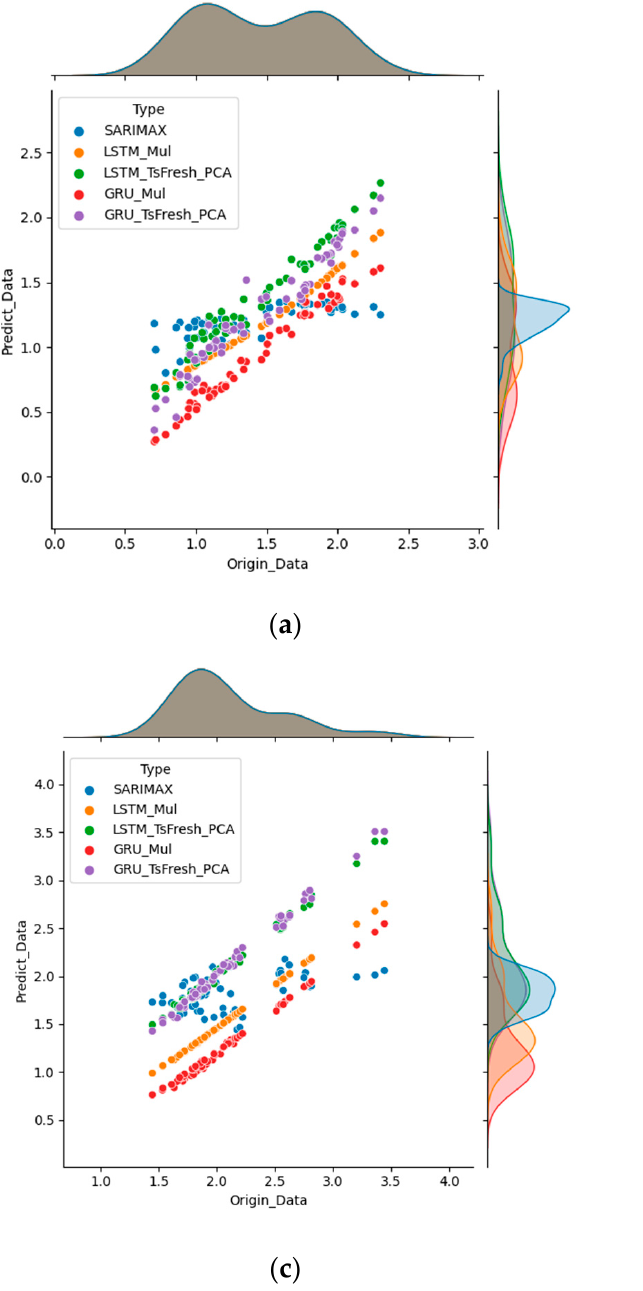
Figure 11. Scatter plots of different model fit. ( a ) Scatterplot of model fit for the spring dataset; ( b ) scatterplot of model fit for the summer dataset; ( c ) scatterplot of model fit for the autumn dataset; ( d ) scatterplot of model fit for the winter dataset.